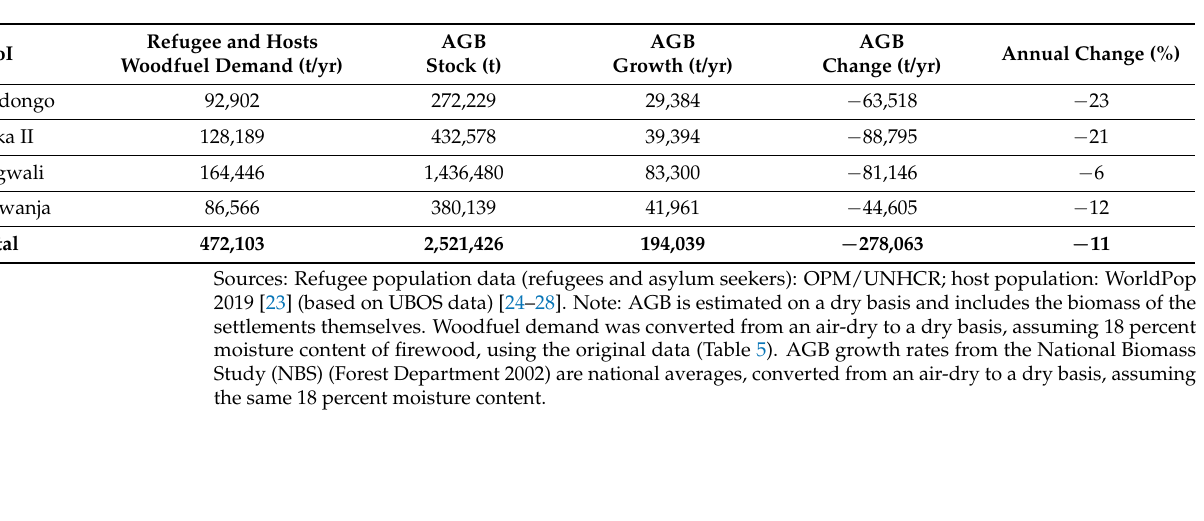
Table 12. Estimated woodfuel demand and supply within the 5 km buffer zone, western and southwestern